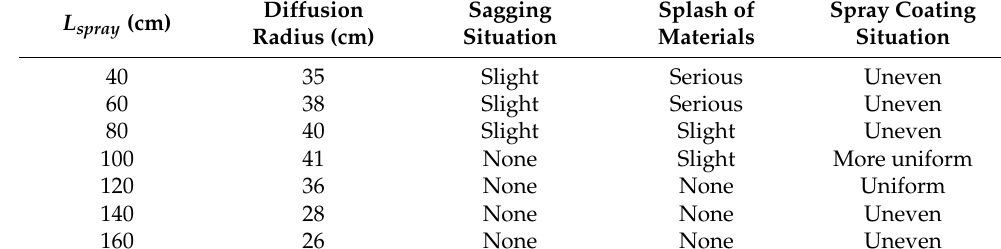
Table 5. Summary of spraying results at different spray gun distances.